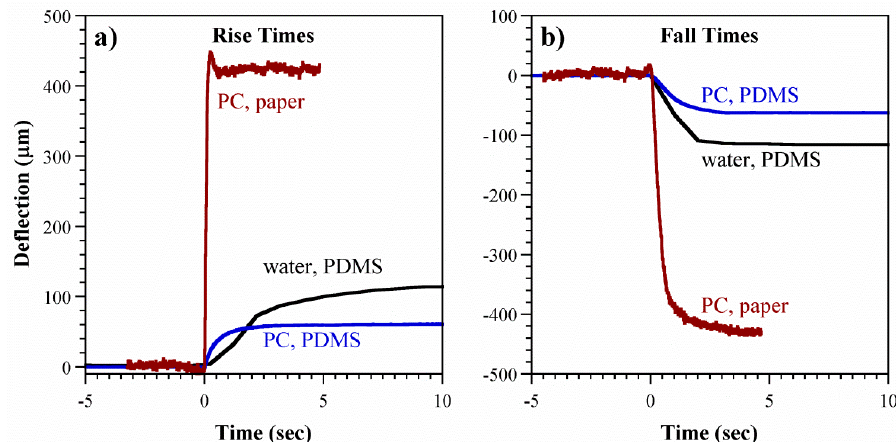
Figure 11. Comparison of deflection-time curves in the stacked configuration and in PDMS microchannel devices. ( a ) Rise times and ( b ) fall times with starting deflections set to zero to allow comparison. (Conditions: load = 1 g; paper/PC, 200 V; PDMS/PC, 7 kV; PDMS/water, 3.5 kV, but times are not voltage dependent).